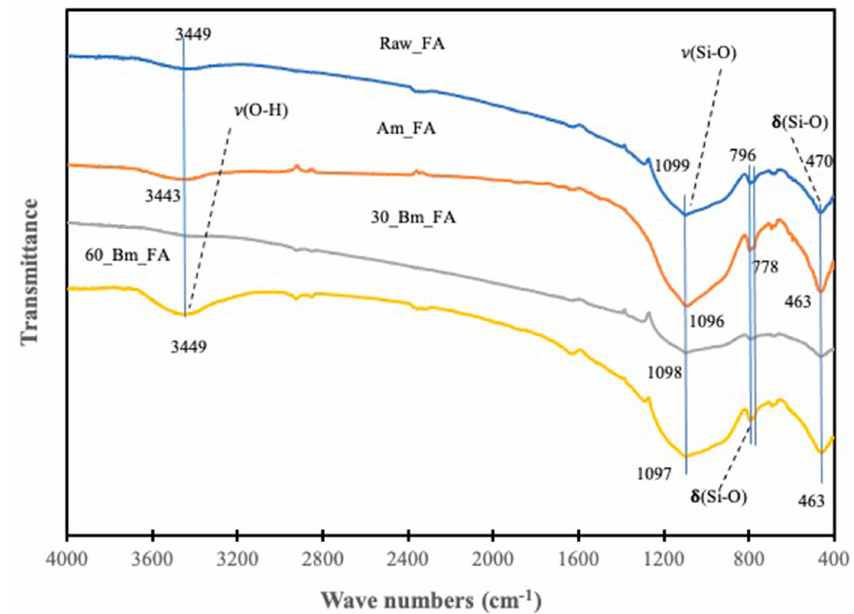
Figure 2. FTIR spectra of the raw and milled fl y ashes. The SEM micrographs of the raw and milled fl y ash samples (Figure 3) indicate that there is li tt le di ff erence in the morphology introduced by milling, with spherical particles observed as reported previously [18]. The sample ball-milled for 60 min shows an agglom- erated microstructure, consistent with the surface area data (Table 1).